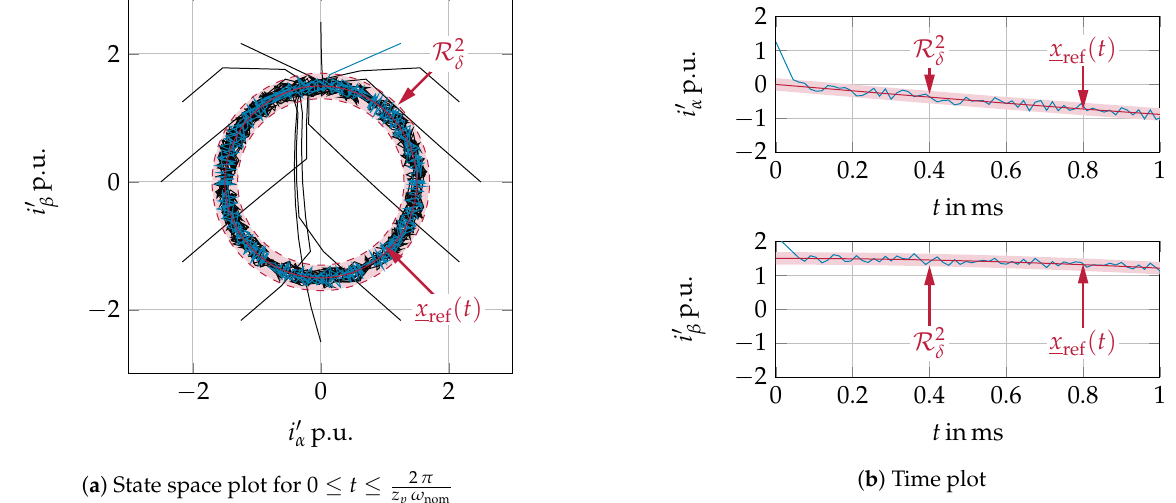
the trajectories of the state variables i (cid:48) value ( k = 11 ) .